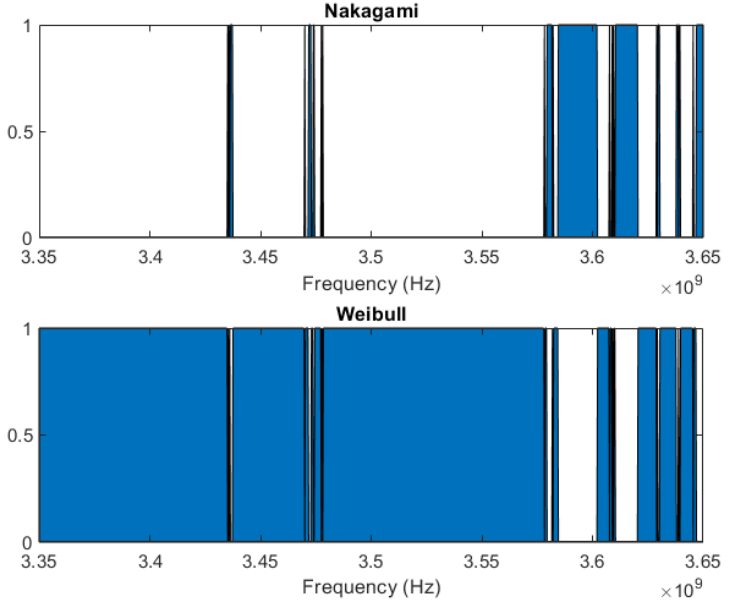
Figure 9. Best-fitted distributions as a function of frequency, at corridor NLoS in the 3 GHz band.